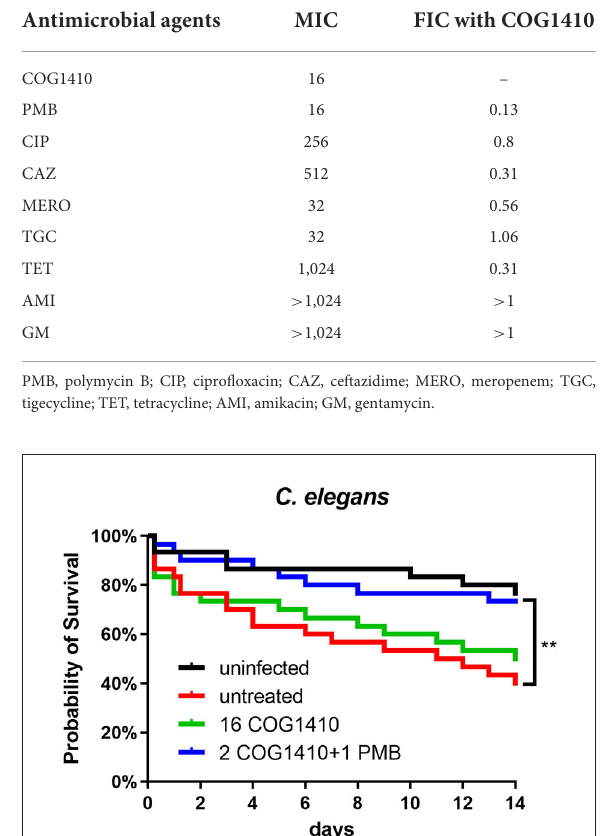
that this combination displayed similar bactericidal activity to 16 µ g/ml concentration of COG1410 (Figure